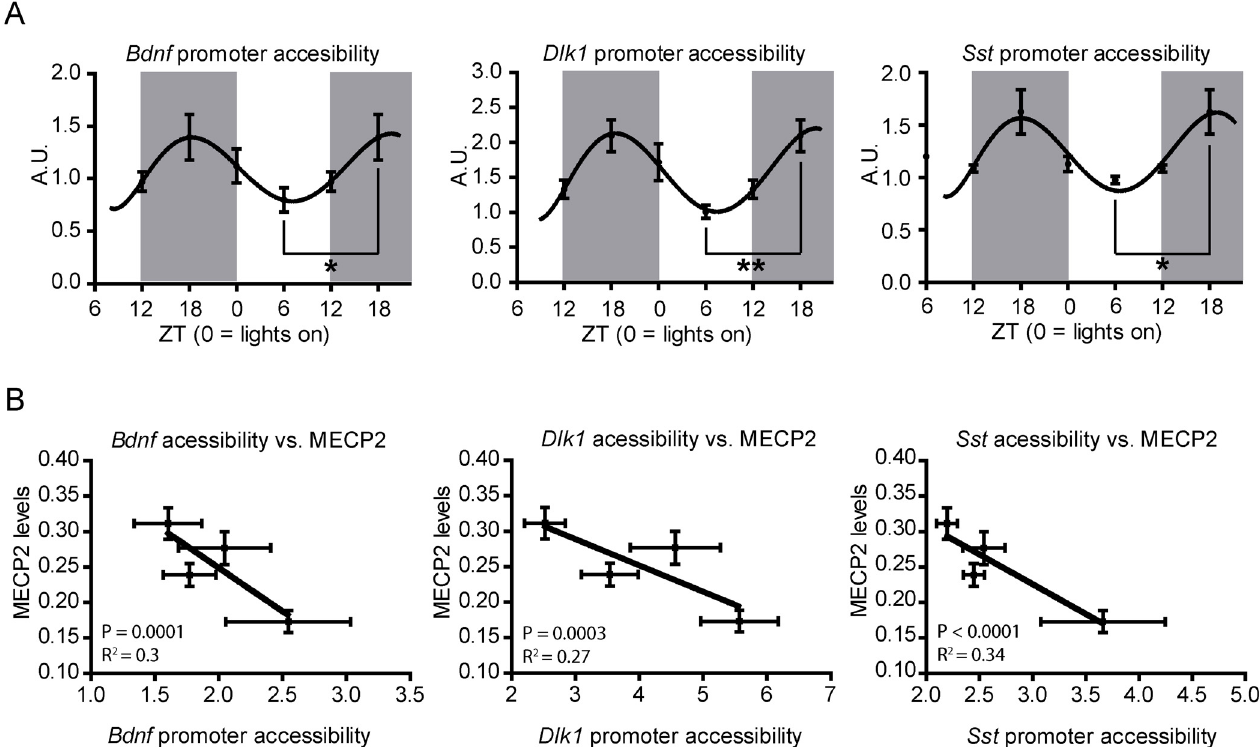
Fig 2. Changes in chromatin accessibility at the Bdnf , Dlk and Sst promoters correlate with MeCP2 levels. (A) MNase digestions, chromatin fractionation, and following RT-qPCRs revealed in all three cases a progression from a less accessible status at ZT 6 to a transcriptionally permissive status at ZT 18 (n = 3 – 5 mice/time point; graphs show mean ± SEM). (B) Correlation of promoter accessibility with MeCP2 levels. * P < 0.05, ** p < 0.005 in two-tailed Student ’ s t -tests. Correlation p-values correspond to the linear regression